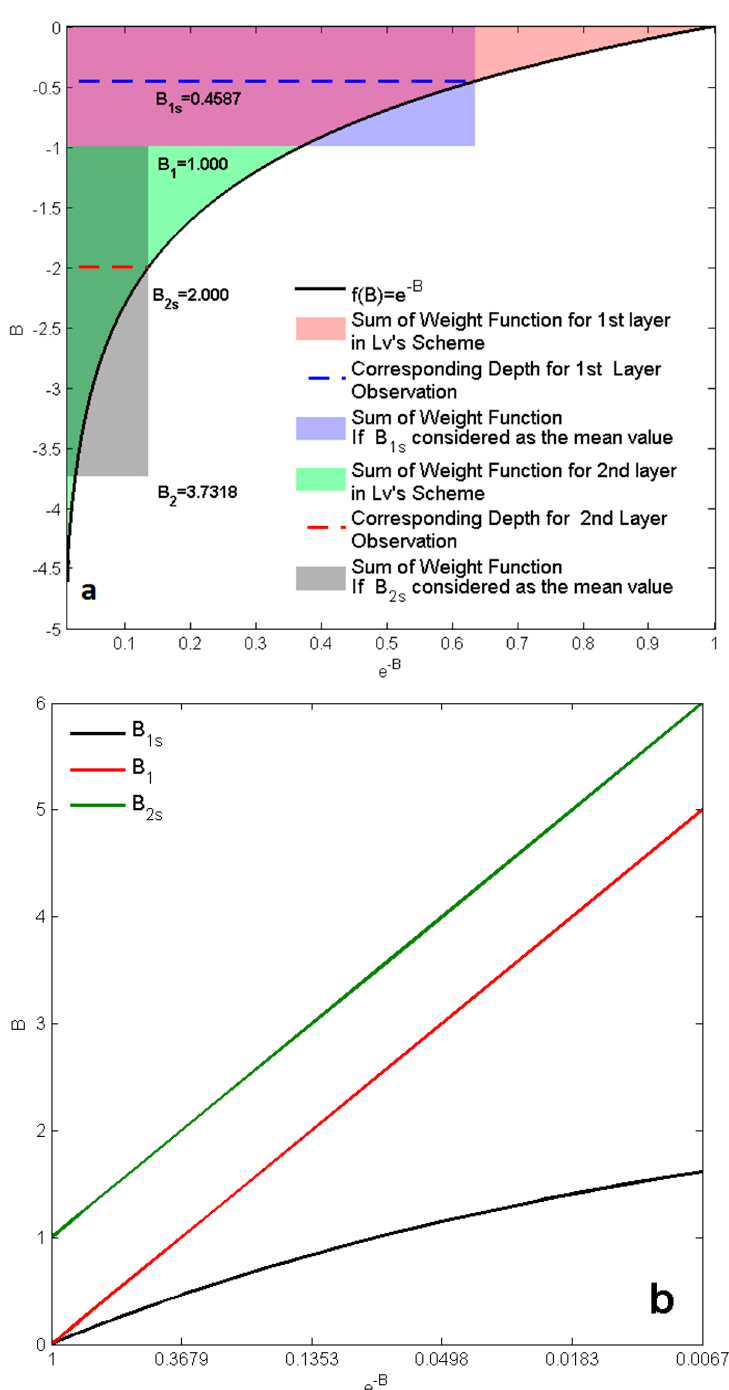
Figure 2. ( a ) Schematic diagram of sampling depth for 21 cm λ= . (cid:1828) 1(cid:1871) and (cid:1828) 2(cid:1871) correspond to the 1 B = ; ( b ) The extension of Figure 2a to